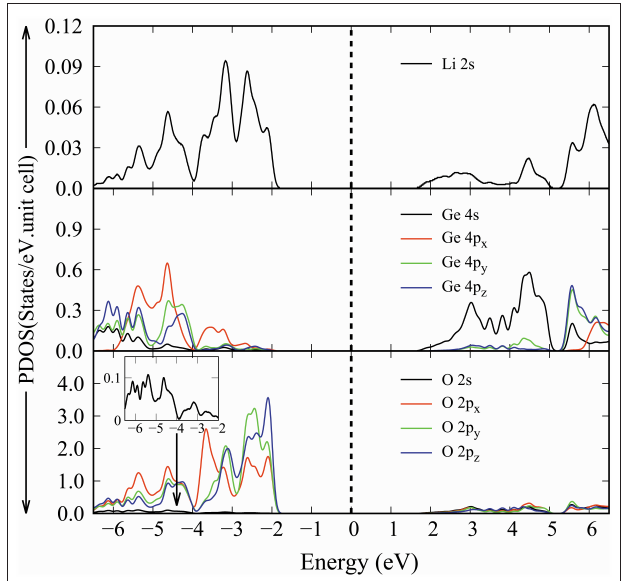
FIGURE 5 | The orbital-projected density of states of Li 2 GeO 3